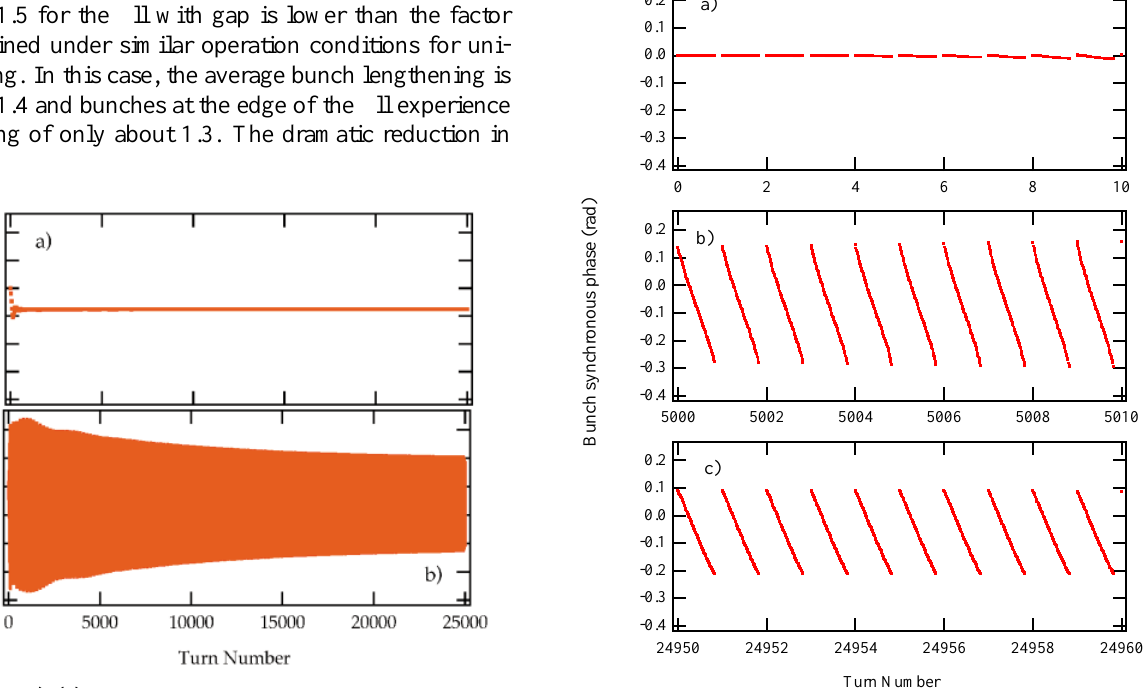
FIG. 4. (Color) (a) Tracking results for a uniform fill pattern, exhibiting no steady-state beam transients (three harmonic cavi- ties tuned to h res (cid:1) 984.32 and I beam (cid:1) 400 mA). (b) Same conditions as (a) but with a 17% gap. This condition demon- strates a large variation in the relative synchronous phase.